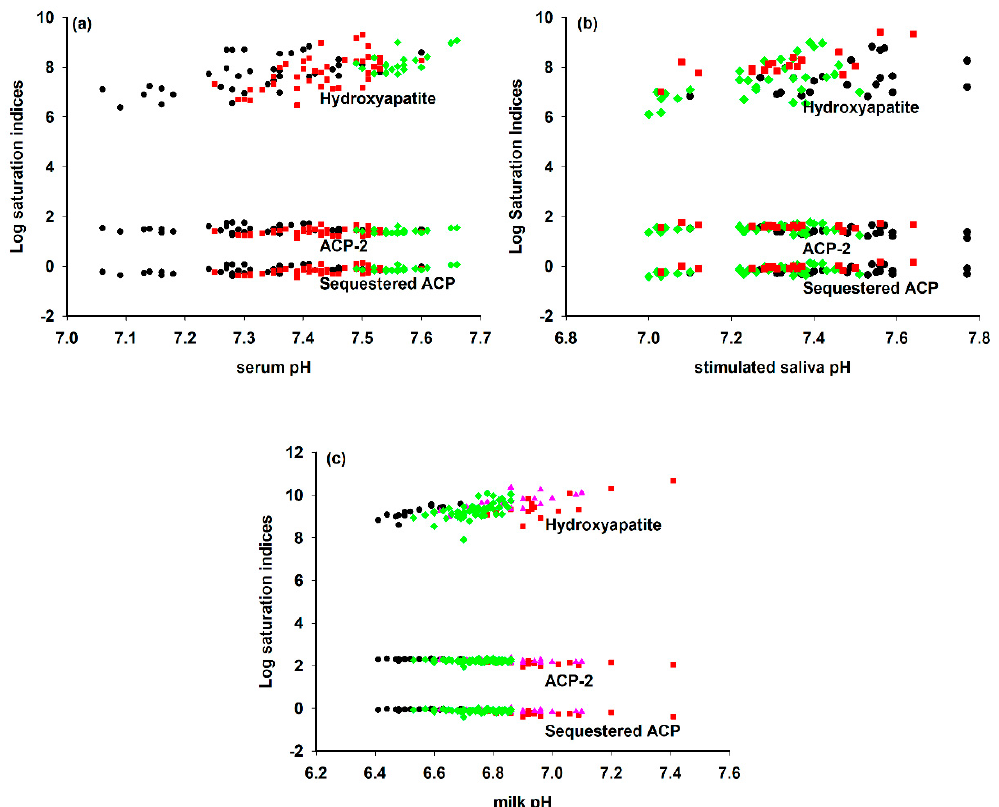
Figure 4. Ion activity products in milk, blood serum and stimulated saliva calculated for three different chemical formulae and divided by the invariant thermodynamic solubility constant for the formula to give the saturation index [13]. The invariant ion activity product of CaP nanoclusters prepared with casein phosphopeptides was used for the milk samples and for the other biofluids an invariant ionic activity product of CaP nanoclusters complexed with the N-terminal OPN 1–149 phosphopeptide was used [24]. ( a ) Human blood ultrafiltrates from subjects who were healthy (green diamond), had hypercalcemia (red square) or renal disease (black circle). Original data from [125,126]. ( b ) Stimulated parotid (black circle), whole (green diamond) and submaxillary (red square) saliva ultrafiltrates. Original data of [122]. ( c ) Bovine milk ultrafiltrates from cows in early (green diamond), middle (black circle) or late (pink triangle) lactation or with mastitis (red square). Original data from [127], modified by [128]. Reprinted with permission from Holt et al. [13] © 2013The Authors. Published by Elsevier Inc. All rights reserved.